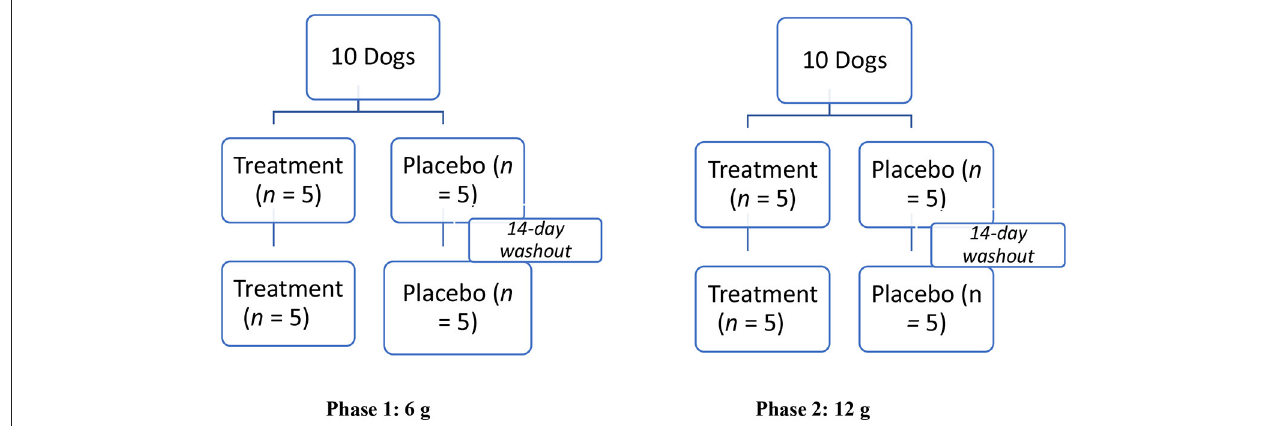
FIGURE 1 | Modified crossover experimental design testing effect of a muscle supplement, Fortetropin ® , on serum myostatin in 10 healthy dogs. Two phases, each with two sequences of the study, were performed. In Phase 1, 5 dogs were randomly assigned to receive a single low-dose (6g) treatment or placebo for the first sequence. After a 14-day washout period, the animals were re-randomized into placebo and the treatment groups. This same protocol was repeated in Phase 2 for the high-dose (12g) treatment or